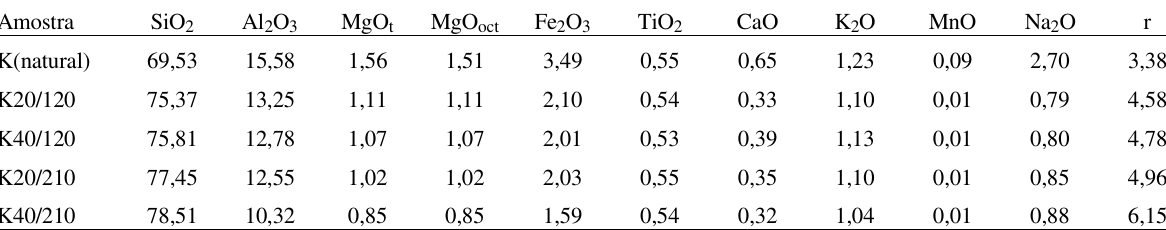
Tabela 1. Composição química das amostras (% de óxidos, em peso).